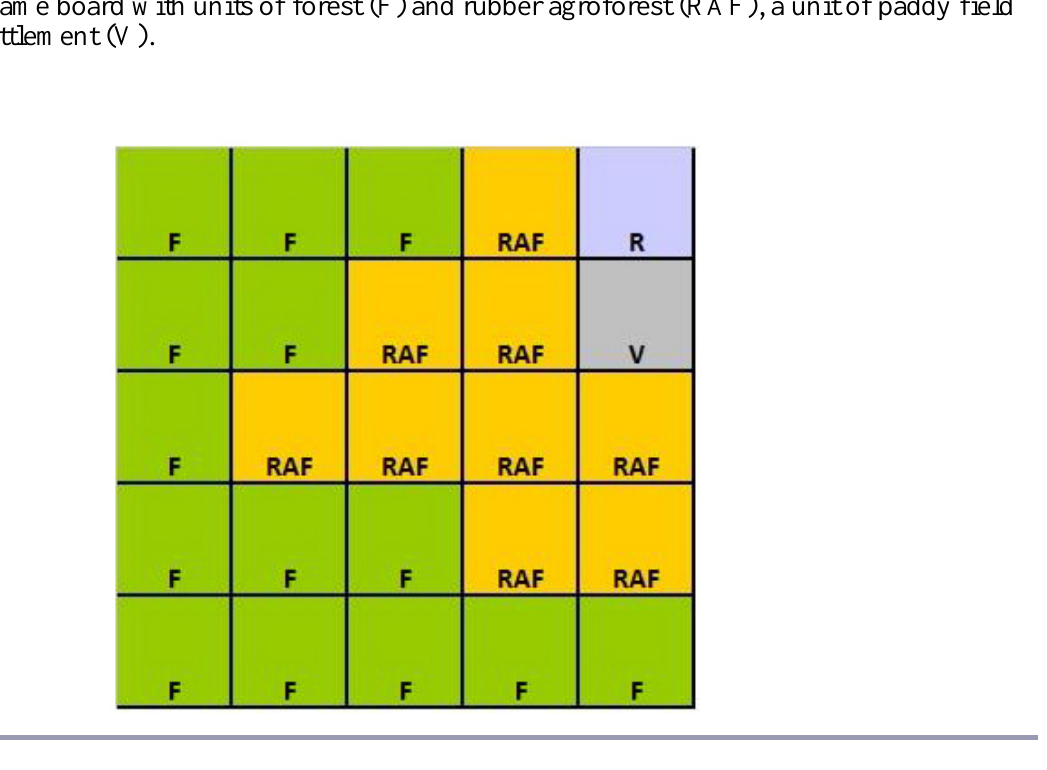
Fig. 4. Land-use game board with units of forest (F) and rubber agroforest (RAF), a unit of paddy field (R), and village settlement